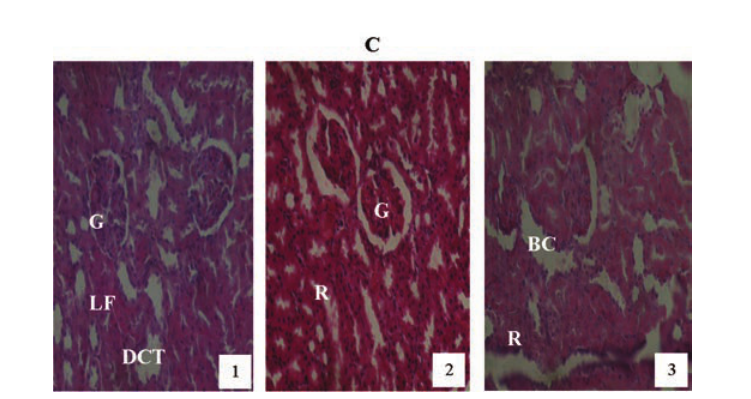
Figure 9. Hematoxylin and eosin staining after administration of 4 mg/kg of paraquat representing test subgroups maintained with no vitamin C medicated drinking water for a period of 3 months (original magnification 400X). The slide at month (1) is showing a picture of shrunken Bowman’s capsules and swollen glomeruli (G), leucocytes infiltration and vascular congestion (DCT) progressing glomerular congestion, intralobular vacuo- lation and renal vascular congestion (R) at month (2). At month (3) the picture indicated advanced renal tubular hypertrophy (R), swollen Bowman’s capsules (BC). Changes increased in an exposure time dependent